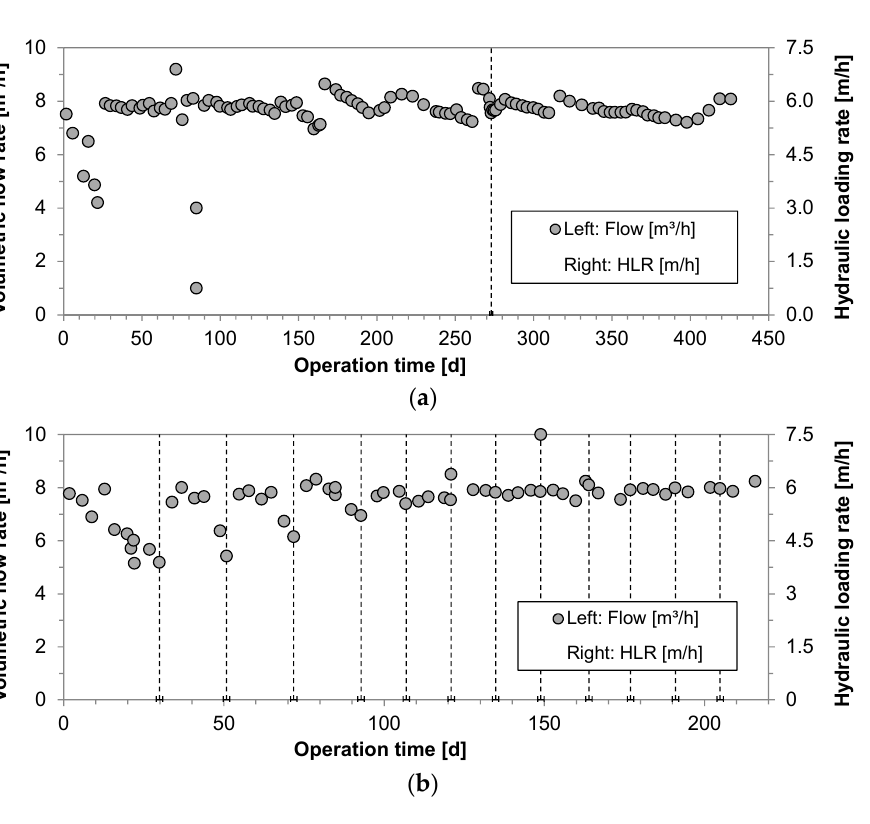
Figure 2. Volumetric and hydraulic loading rate (HLR) during operation of ( a ) two fixed-bed adsorbers in series fed with drinking water; and ( b ) a single fixed-bed adsorber fed with un-aerated groundwater. Backwashes are indicated by dotted lines.